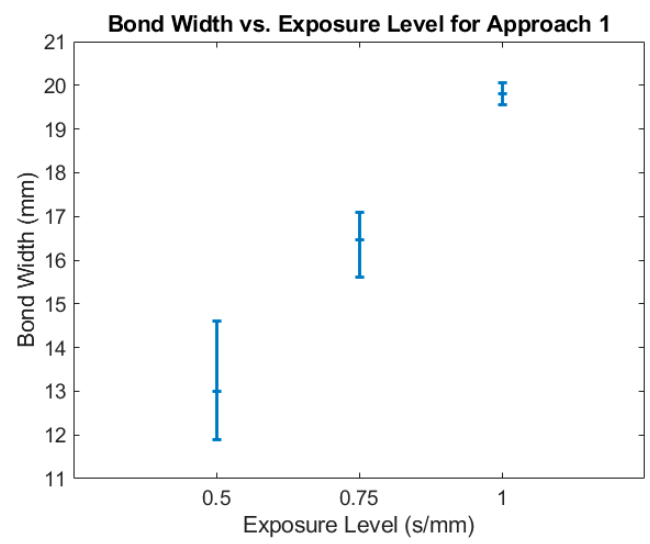
Figure 7. Measured bond width at 3 exposure levels.